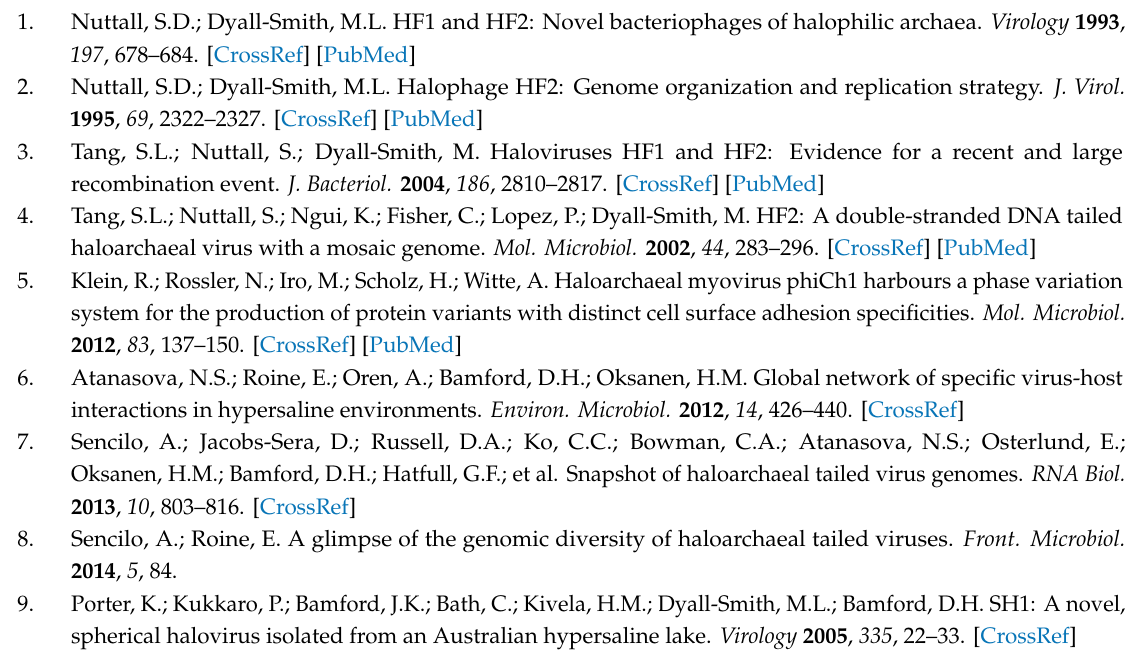
Table S1: Revisions to the genome sequences of HF1 and HF2, Table S2:, Absent 6-mer palindromic restriction sites in all HF1-group viruses, Table S3: Palindromic 6-mer motifs present only in one or two HF1-group viruses, Table S4: Taxonomic predictions of HF1-group viruses using the VICTOR suite of programs. Figure S1: N-6 methyltransferases encoded by HF1-group viruses and proviruses, Figure S2: Mass spectrometry results for HF2 virus proteins VP1–VP4, Figure S3: Class I and Class II intergenic repeats (IR) of halovirus HF2 [4] compared to the corresponding sequences of Hardycor2 and